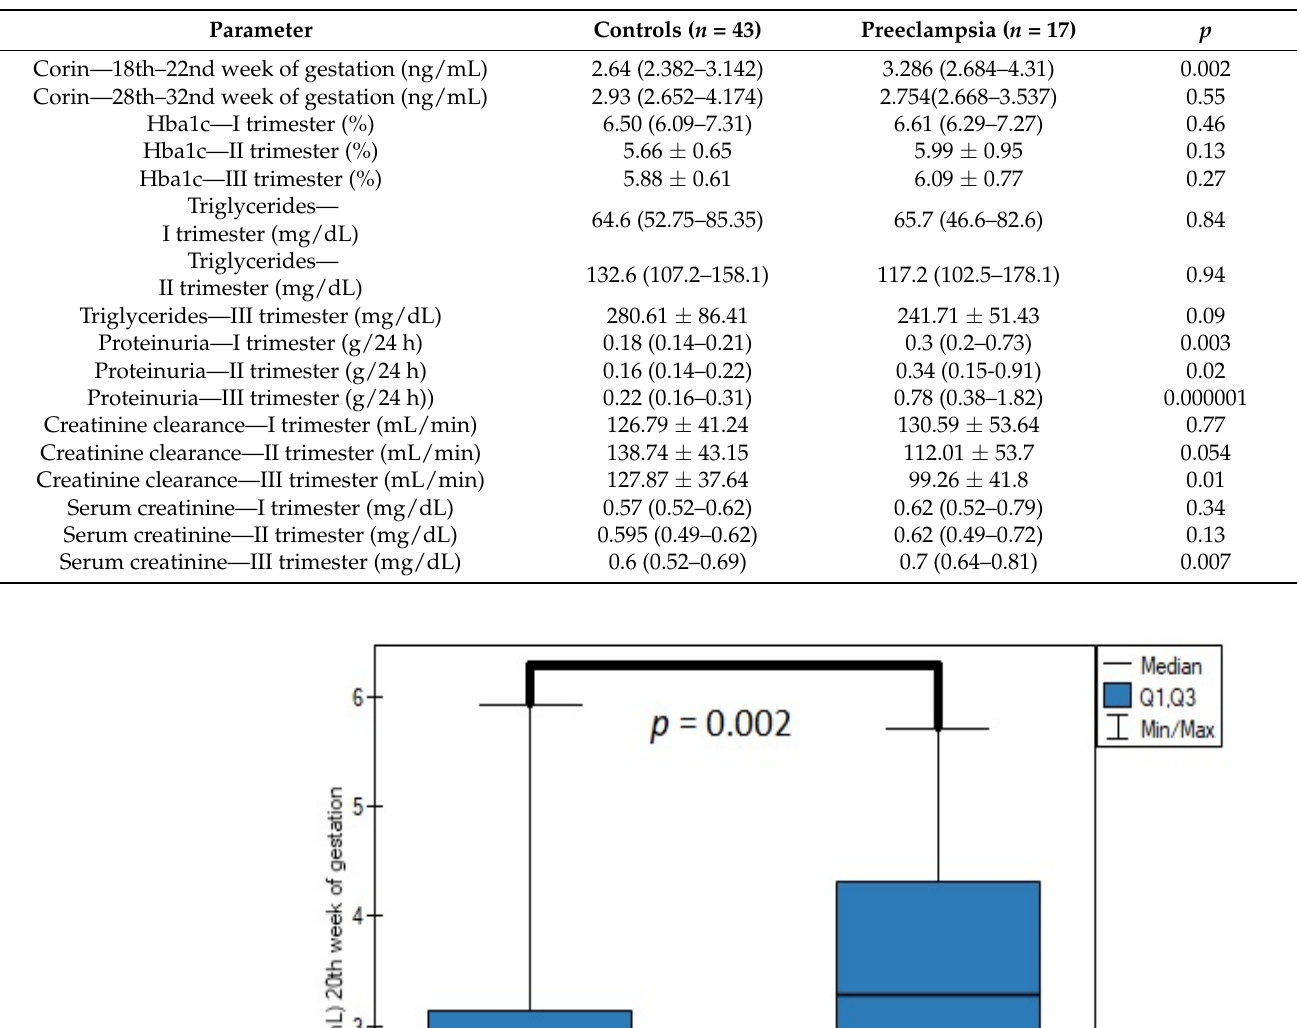
Table 2. Differences in biochemical parameters between PE patients and the control group.